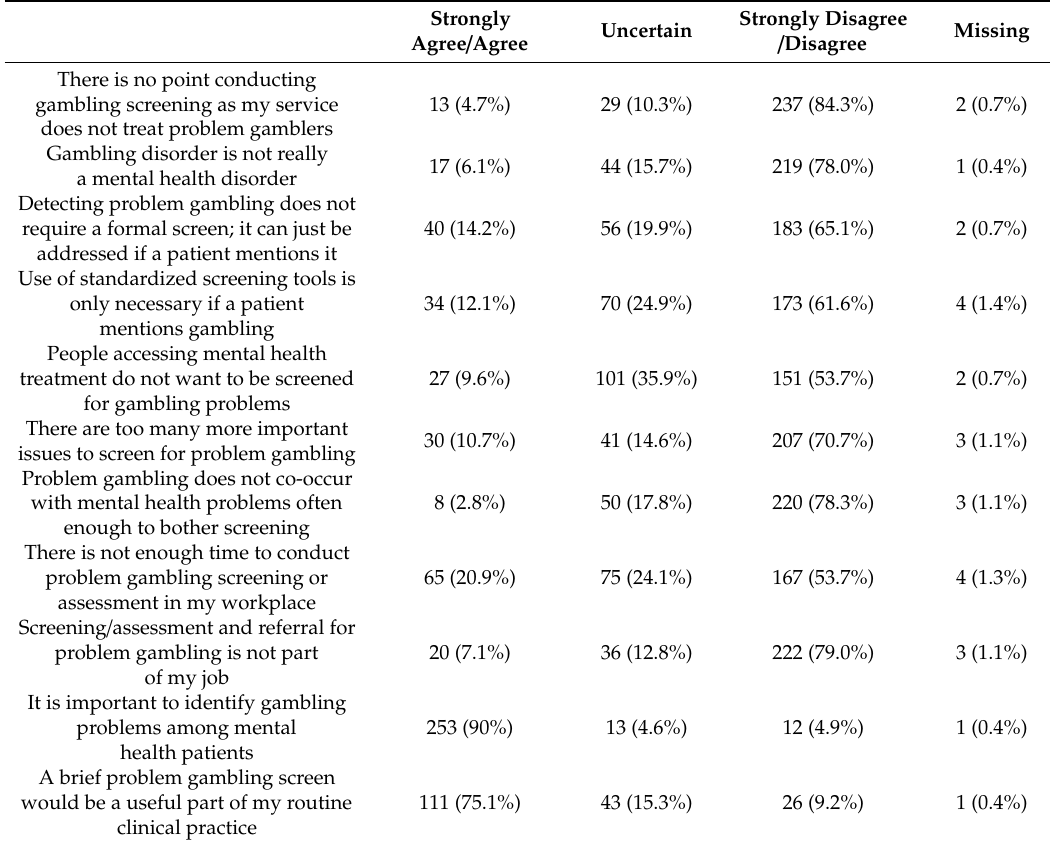
Table 3. Attitudes towards responding to gambling issues.